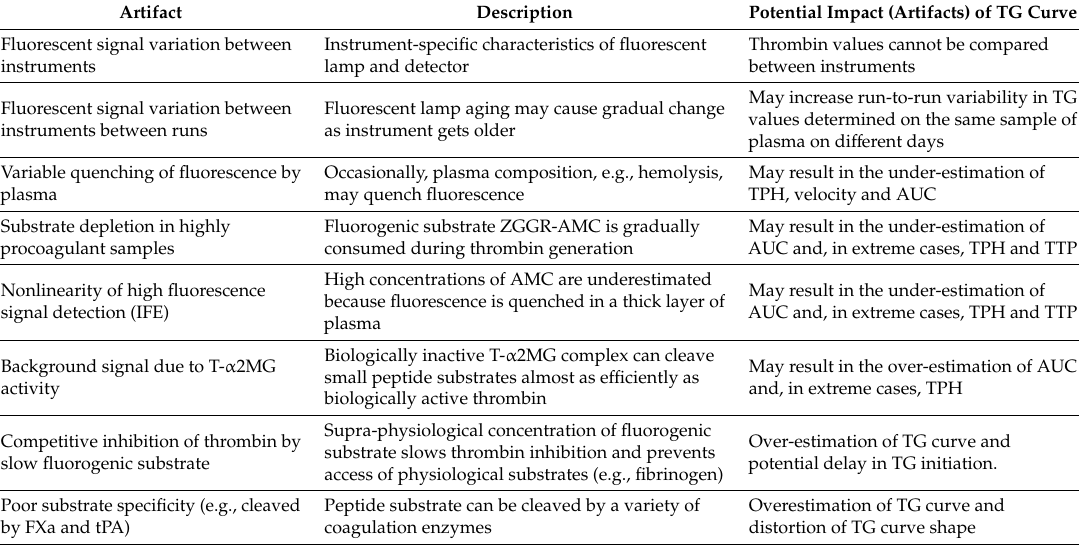
Table 1. Known artifacts caused by fluorescent substrates in TG